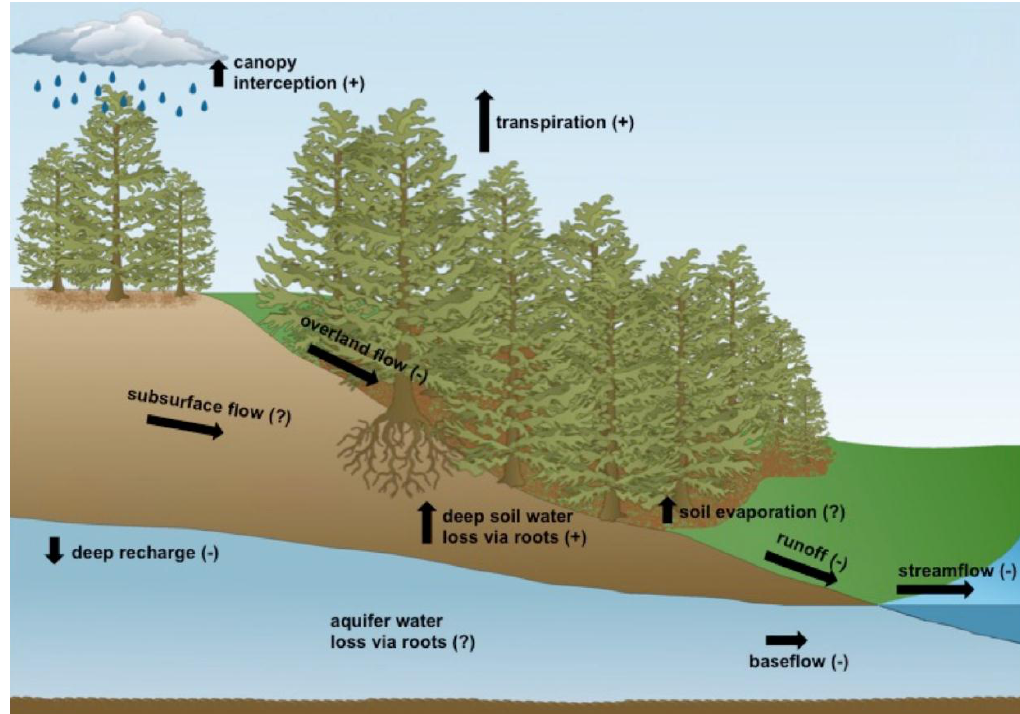
Figure 3. Graphic illustration of the current state-of-the-science on the alteration of hydrological components following a grassland transition to redcedar woodland. Arrow shows the direction of the flux or the flow path of each component. “+”, “-“, and “?” in the parenthesis represents “increase”, “decrease”, or “uncertain” of the magnitude of each component, respectively.